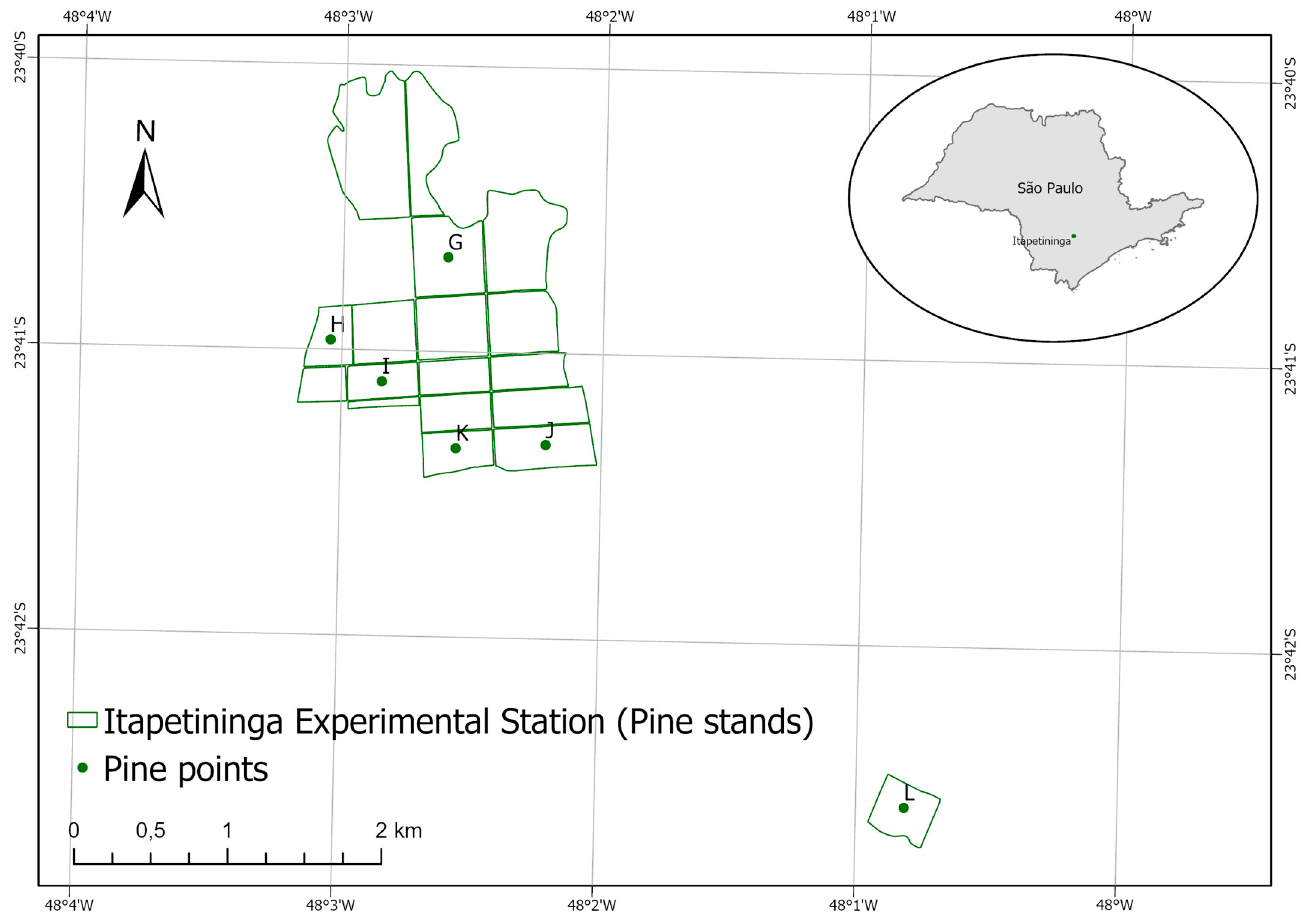
Figure 3. Location of the pilot area within the municipality of Itapetininga, in São Paulo State. The sample points are highlighted in the figure.